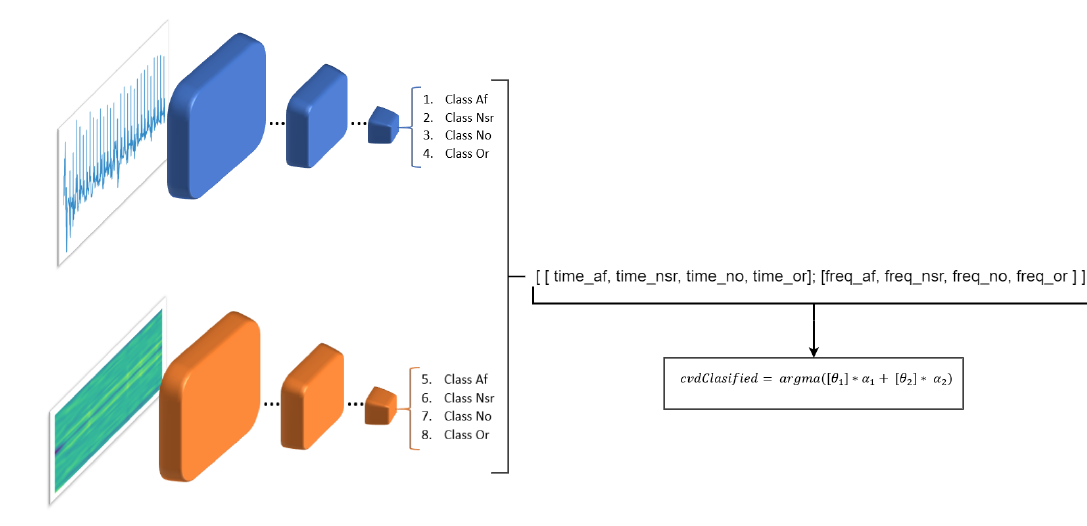
Figure 13. Merging process of the two classifiers.